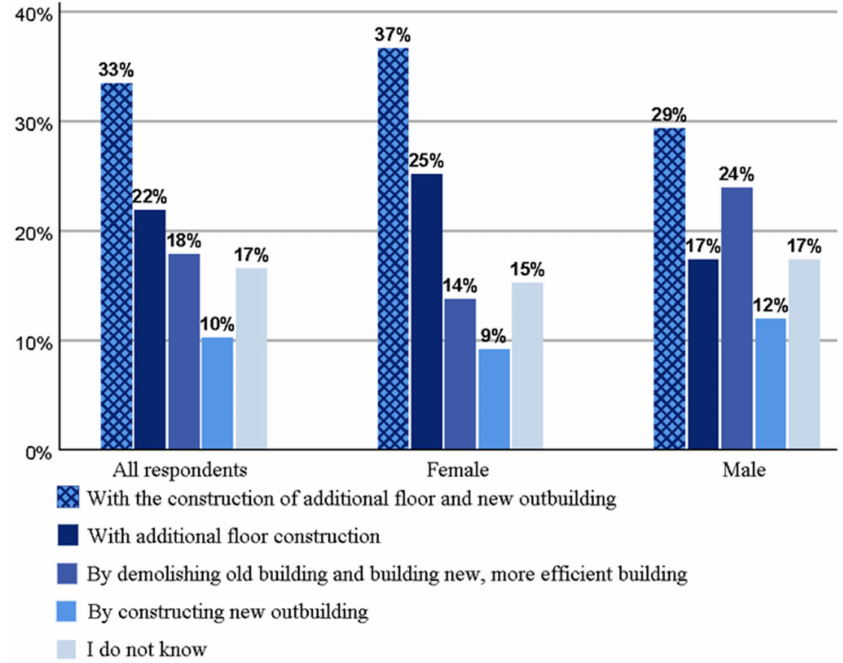
Figure 7. Preferred ways to implement additional construction in residential areas.